Question: Provide a one-line summary of what is displayed.
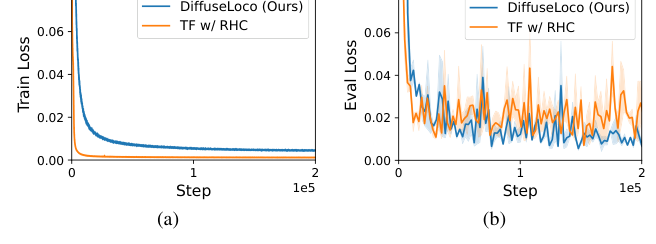
Answer: Loss curves for training DiffuseLoco and TF w/ RHC baseline. (a): Training Loss. (b): Evaluation Loss. We report mean and standard deviation across three seeds. We find that even though TF w/ RHC achieves a low reconstruction loss in training, the evaluation loss stays higher than DiffuseLoco and increases at the end. This indicates TF w/ RHC tends to overfit the offline datasets while DiffuseLoco is not, with the same number of parameters.